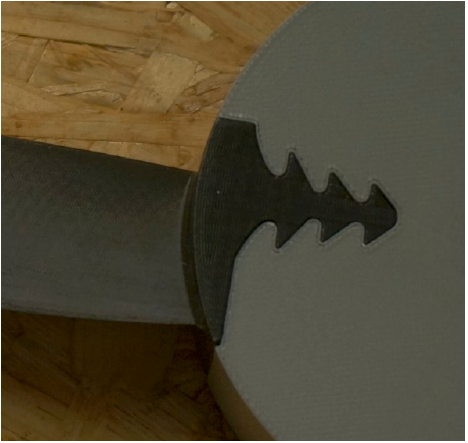
Figure 3. Connection between blade and hub (“fir lock”).